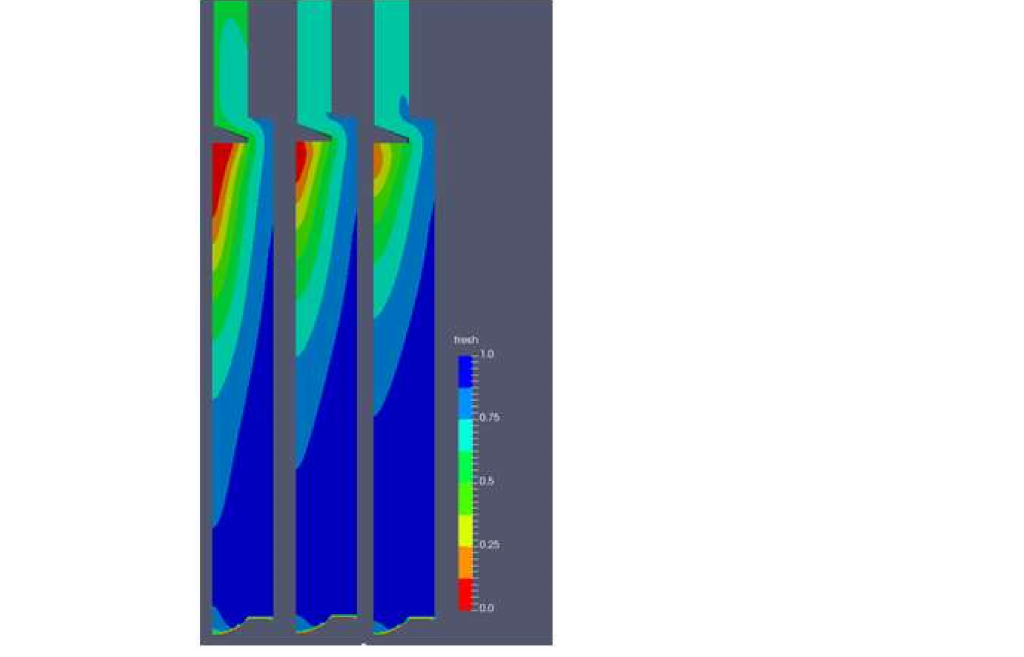
Figure 10. Fresh air propagation for the moment CA = 200 ◦ for the cases with pressure difference 0.25, 0.3, and 0.35 bar respectively, from left to right. The depicted contours represent fresh air concentration (fresh air mass [kg]/total mass [kg]).